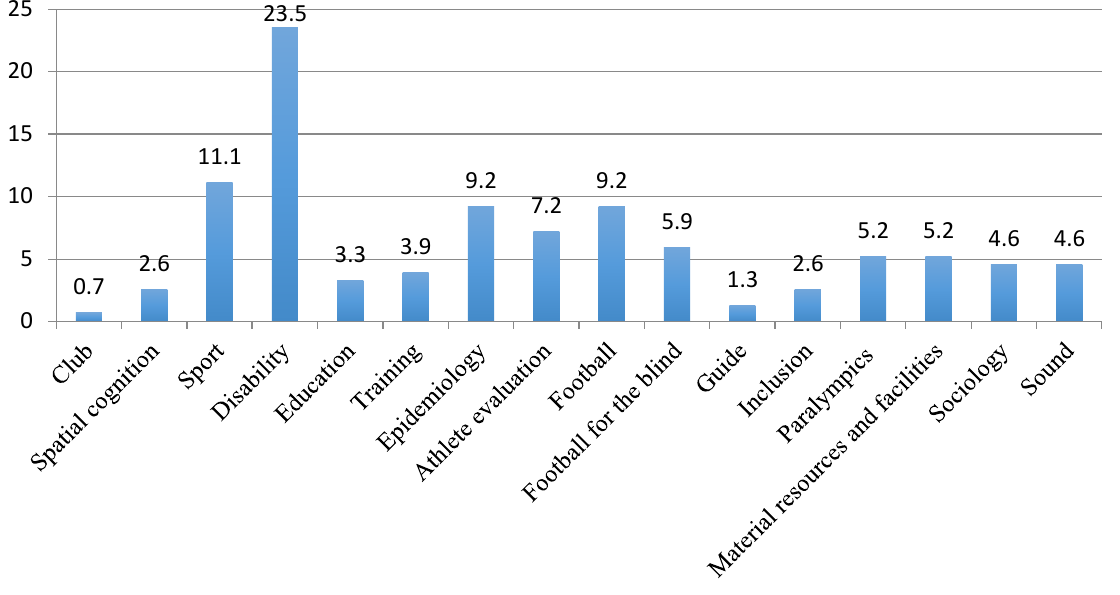
Figure 3. Most important keywords related to 5-a-side football for individuals with visual